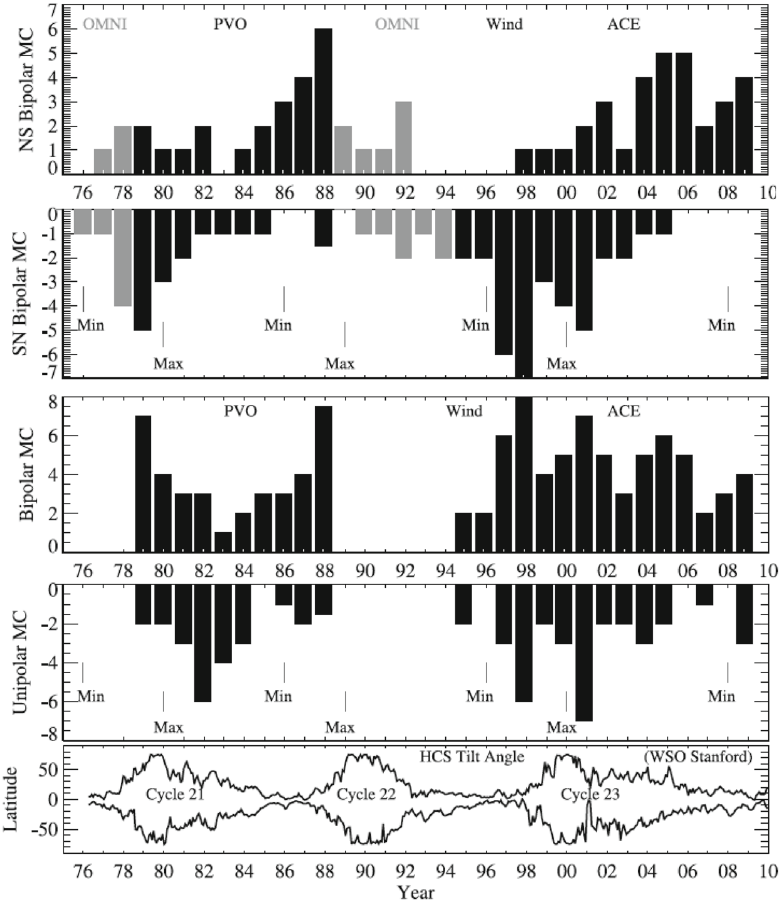
Fig. 24 Solar cycle variations of NS- and SN-type bipolar magnetic clouds, and bipolar (S and N types combined) and unipolar (SN and NS types combined) magnetic clouds in the near-Earth solar wind. The four first panels show the annual counts and the fifth panel shows the N and S tilt angle of the heliospheric currentsheet.ThefluxropetypesareillustratedinFig.5.Inthisfigurethelettersreferonlytothenorth-south magnetic field component (e.g., N can present both ENW and WNE type flux ropes). Image reproduced by permission from Li et al. (2011), copyright by Springer, where the third panel was erroneously labeled